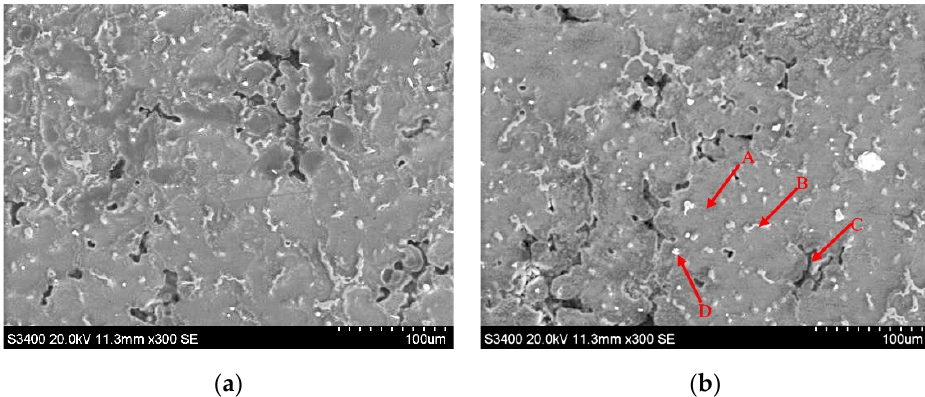
Figure 4. SEM images and XRD results of weld metal under flux coating amount of 3 mg/cm 2 . ( a ) SEM image of applying no magnetic field; ( b ) SEM image of exerting magnetic field.